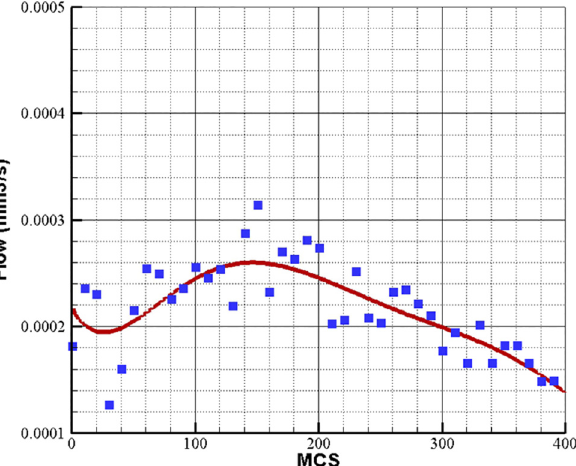
Fig 14. Blood flow in a closed loop with 30 Pa pressure difference in inlet and outlet of the loop. Blood viscosity depends on vessel diameter and hematocrit. The flow data is averaged over 10 independent